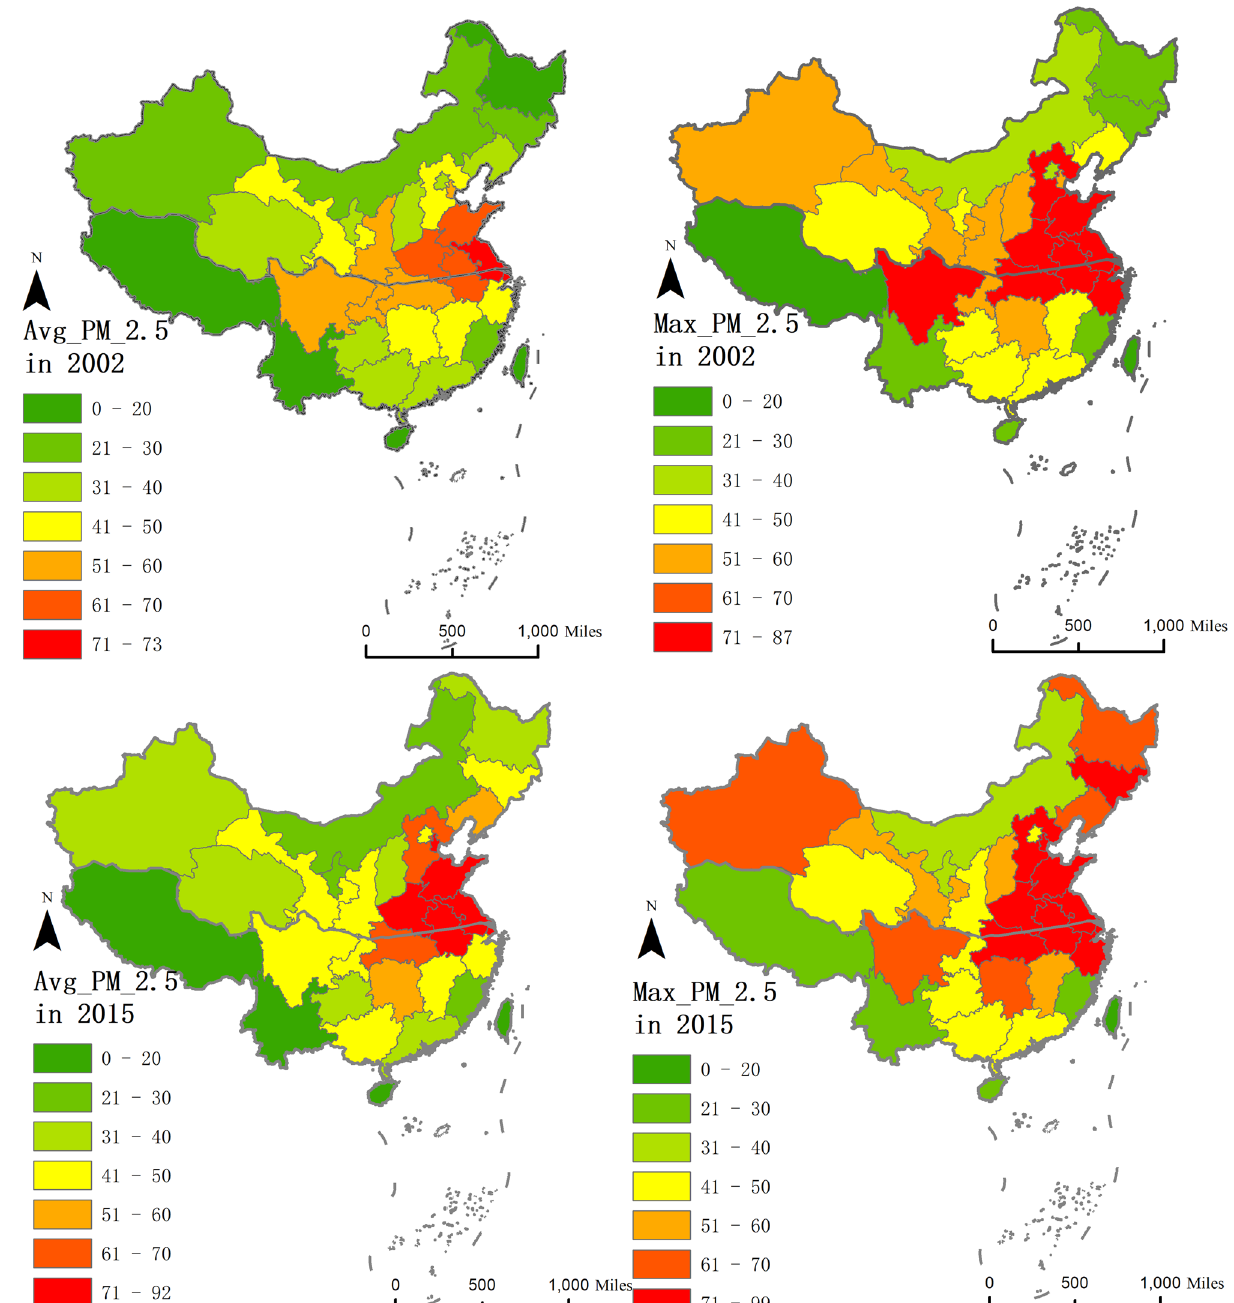
Figure 1. Spatial distribution of PM 2.5 in 2002 and 2015 (µg/m 3 ), respectively. The left two maps are the spatial distribution maps of average PM 2.5 pollution concentration in 31 provinces in 2002 and 2015, respectively, and the right two maps are the spatial distribution maps of maximum PM 2.5 pollution depth in 31 provinces in 2002 and 2015, respectively. Maps generated in ArcGIS